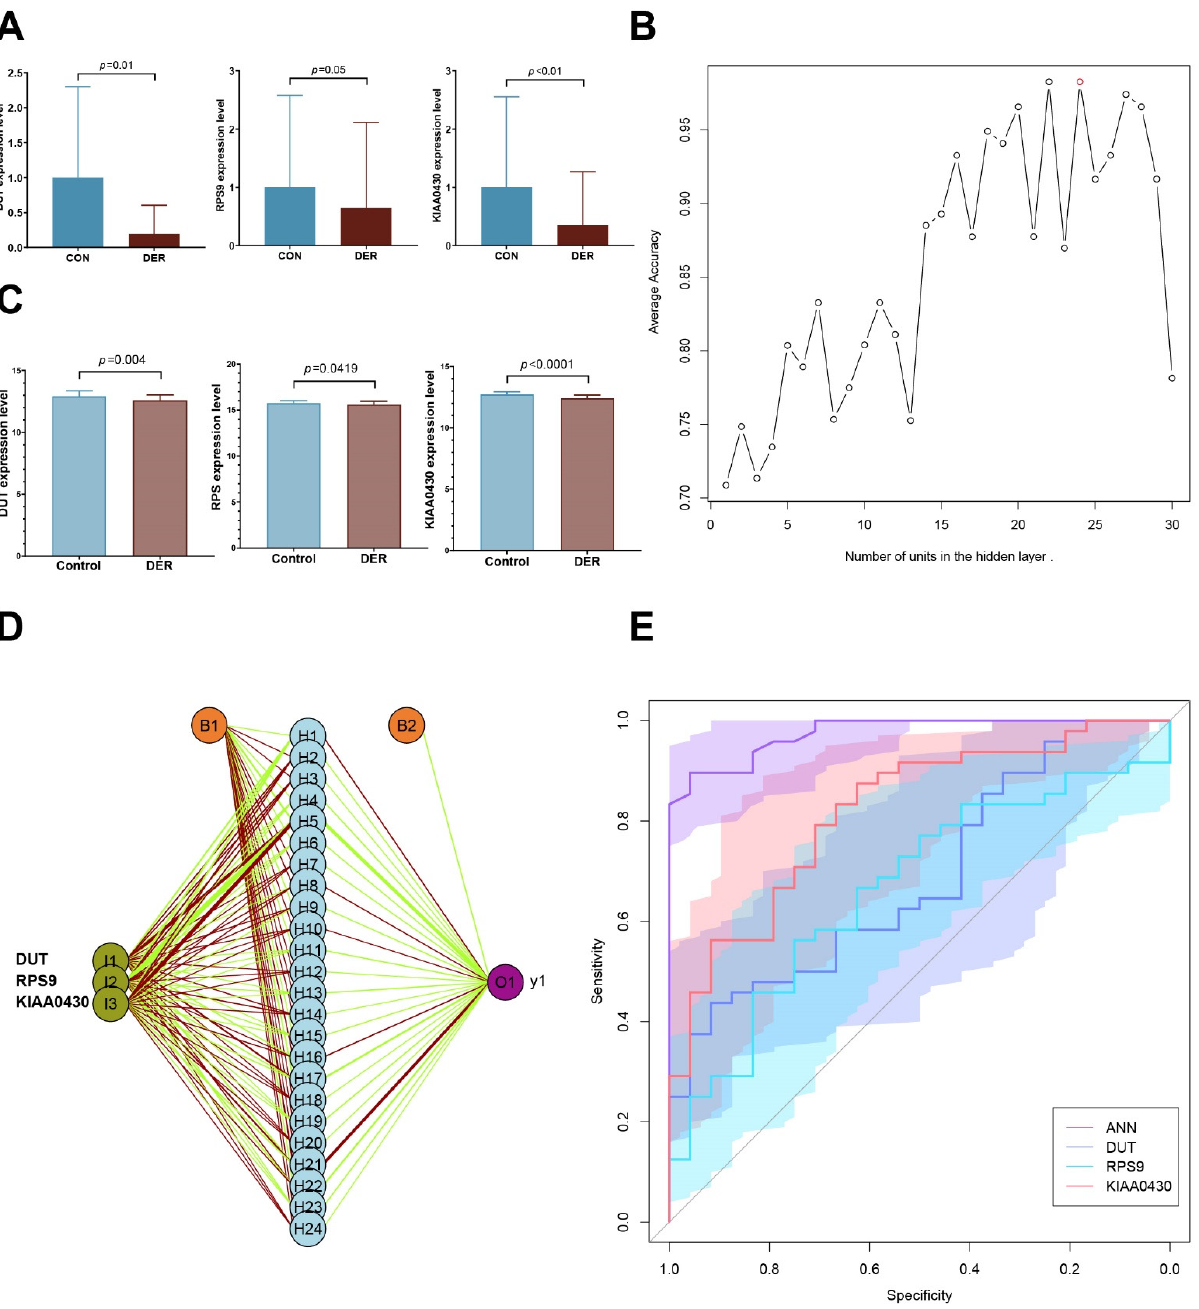
Figure 5. Artificial neural network prognostic model. ( A ) Validation of mRNA expressions of hub genes in DER ( n = 10) and control ( n = 9). ( B ) Average accuracy of each number of units. Twenty-four units exhibited the greatest accuracy (98.3%). ( C ) Expression levels of hub genes. ( D ) Schematic pre- sentation of the ANN model for predicting DER. Dark green represents transmission of information from hub genes. Green and red colours represent positive and negative weights, respectively. Light blue represents the bias applied to hidden neurons. ( E ) ROC of ANN and single genes. AUCs of ANN, DUT, RPS9, and KIAA0430 were 0.975 (0.945–1), 0.688 (0.563–0.814), 0.665 (0.535–0.795), and 0.818 (0.716–0.919), respectively.